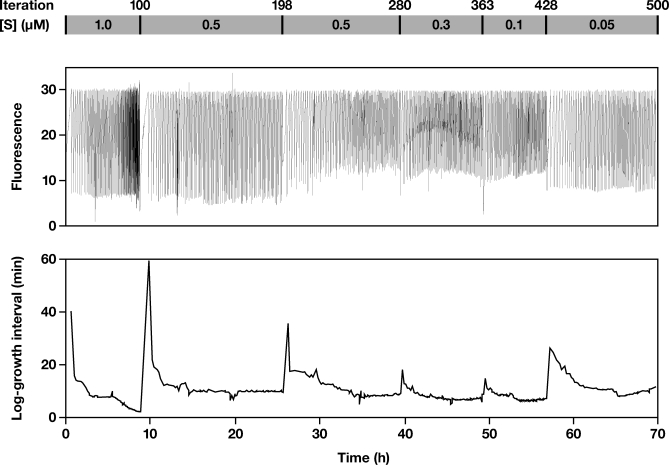
Chip-Based EvolutionRNA enzymes were evolved over the course of 500 logs of selective amplification. The population was monitored in real time based on fluorescence intensity (middle). After each log of growth, a 10-fold dilution was executed by automated microfluidic manipulation. The substrate concentration was reduced periodically to maintain selective pressure on the evolving population (top). Before each reduction in substrate concentration, sample was removed from the circuit, mutagenized, and reintroduced to the circuit. The interval between successive dilutions was recorded as a function of time (bottom).